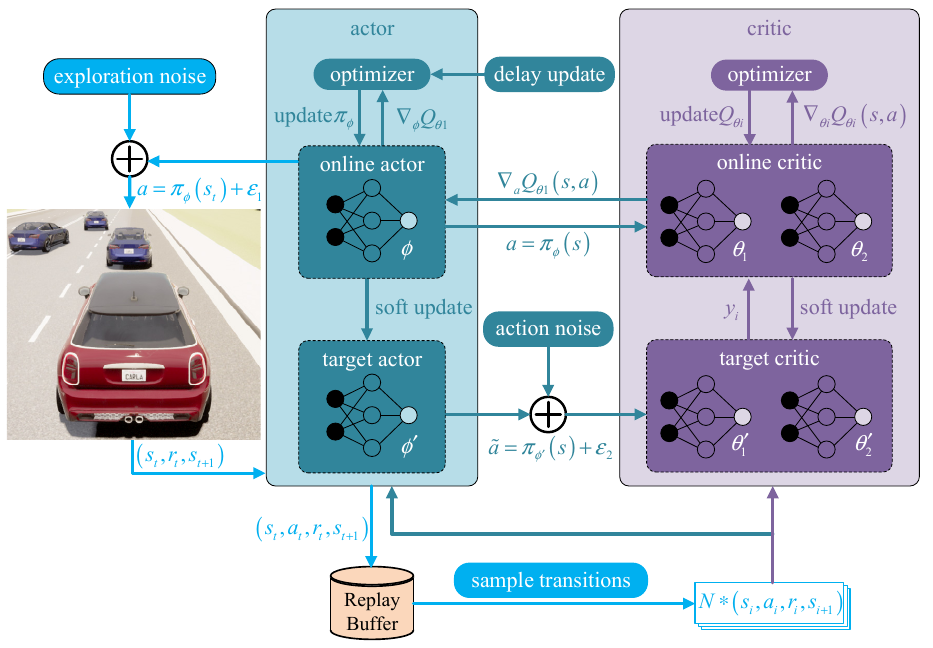
Figure 1. The improved TD3 network in this paper.